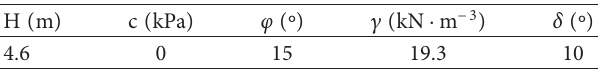
Table 1: Basic parameters of a cohesive-less backfill retaining